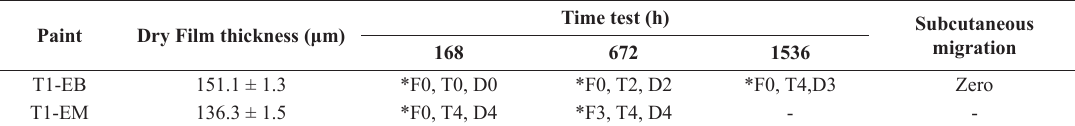
Table 4. Results of salt spray testing for